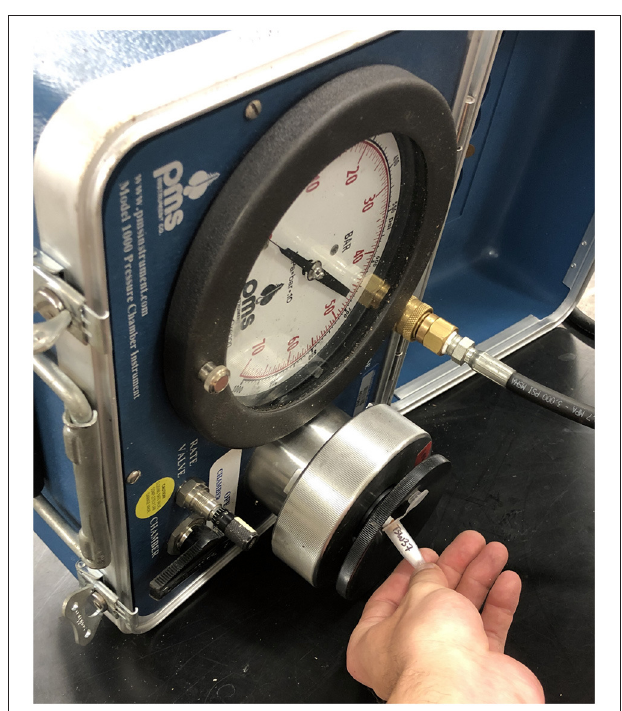
FIGURE 2 | Example of collecting Stem-PC sample into Eppendorf tube filled with glass wool and the PMS instruments Model 1000 pressure chamber instrument on its side so that gravity helps facilitate the collection of